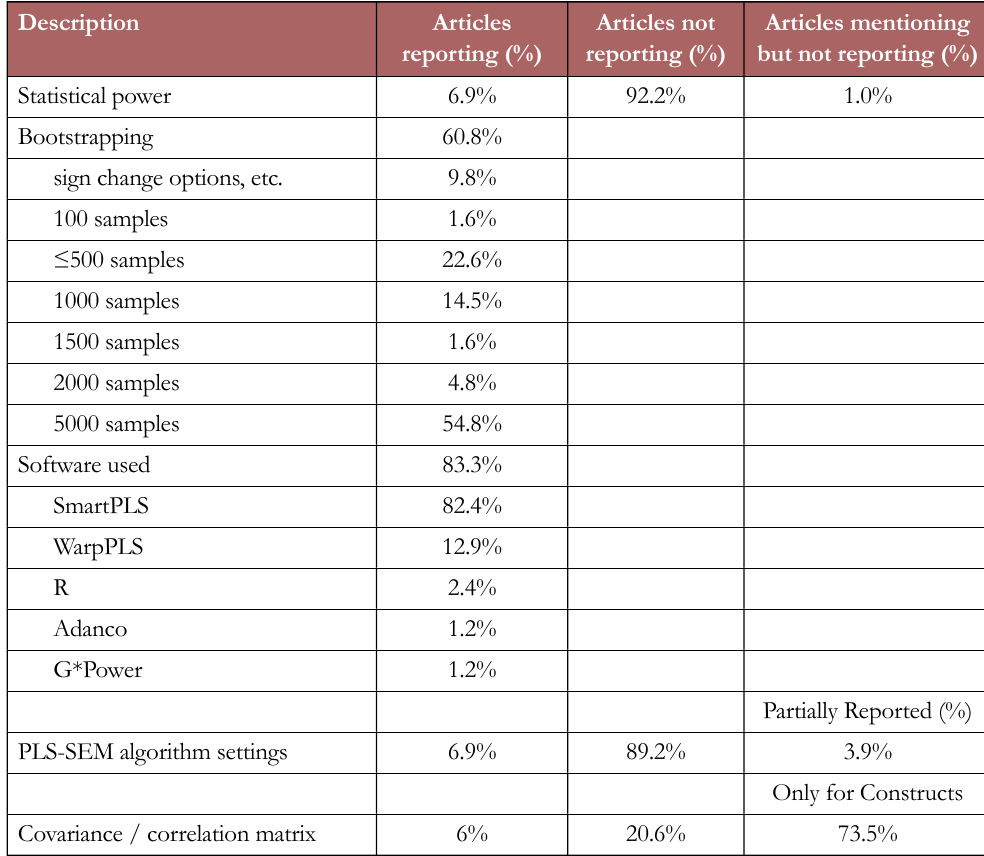
Table 10. Reporting of other aspects